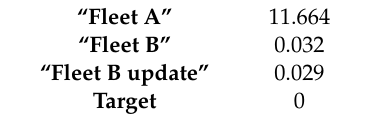
Table 8. Failure-weighted mean-square value (FWMSV) Adjustment evaluation